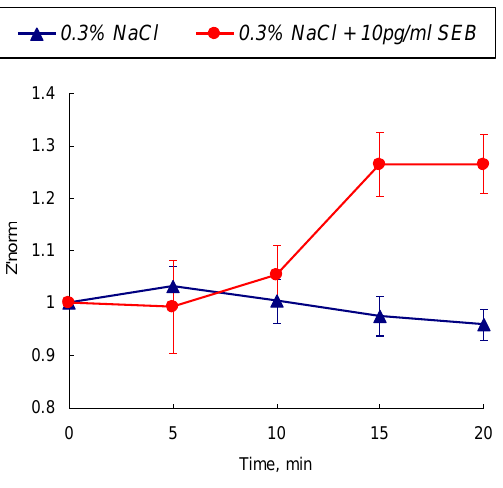
Figure 7. Normalized value of Z  at a single frequency (31 kHz) electrochemical norm impedance of a polarized SEB immunosensor in 0.3% NaCl and 0.3% NaCl + 10 pg/mL SEB media as a function of